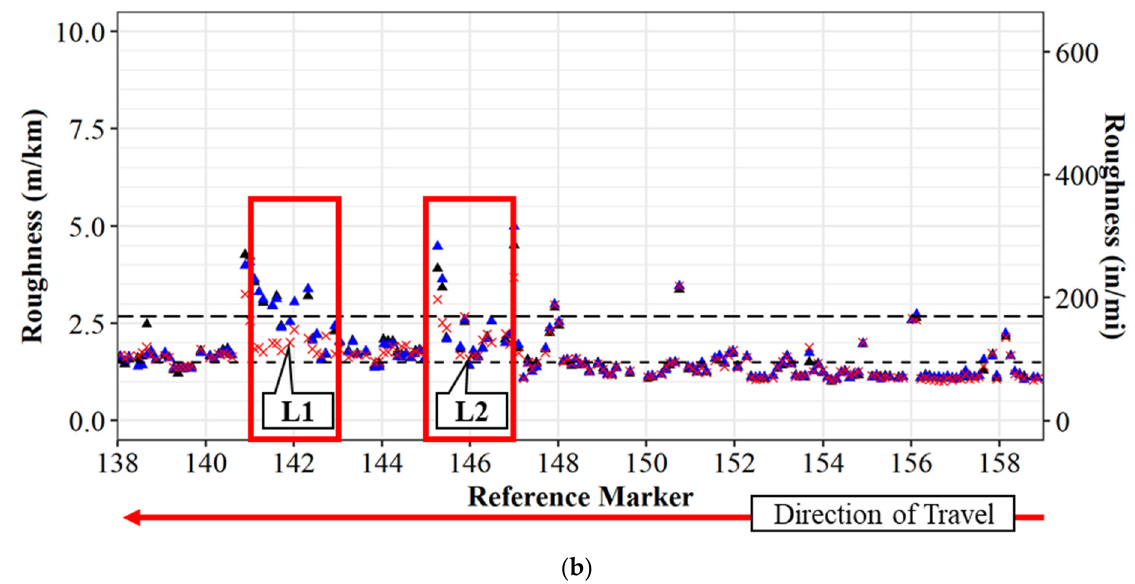
Figure 12. IRI comparison on I-65 from March 2022 to July 2022: ( a ) I-65 northbound 3-month analysis; ( b ) I-65 southbound 3-month analysis. Callout (L1) reference marker 142 shown in Figure 13a,b; (L2) reference marker 146 shown in Figure 13c,d.